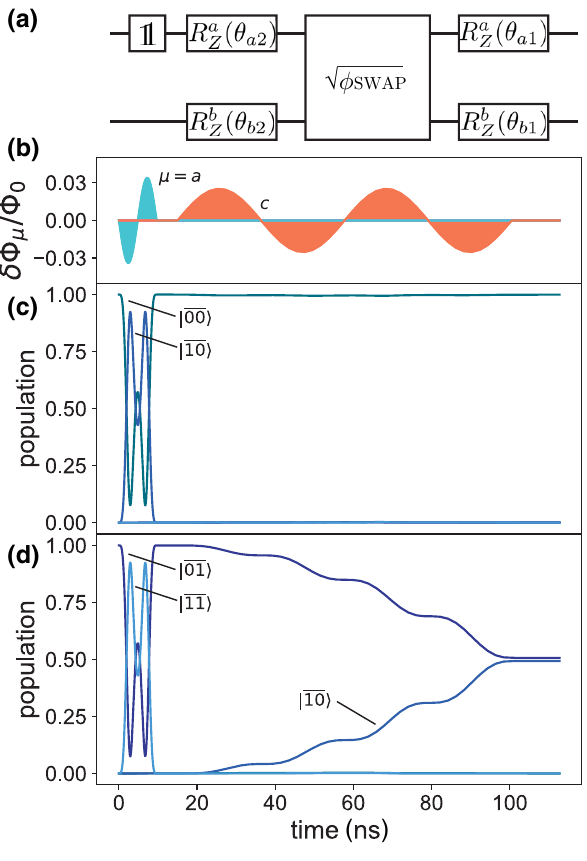
√ √ φ SWAP gate and FIG. 8. A i SWAP gate composed of a corrective Z rotations. (a) A quantum circuit representation of the flux pulses shown in (b). The qubit flux δφ a ( t ) (blue) is modulated to achieve the required identity operation, while the coupler flux δφ c ( t ) (orange) is activated to entangle the qubits. Single-qubit Z rotations are obtained during the time spent idling. (c) The time evolution with the initial state | 00 (cid:5) . The popula- tion transfer to the | 11 (cid:5) or other states is negligible during the √ φ SWAP time window. (b) The time evolution for | 01 (cid:5) as the initial state. The | 01 (cid:5) and | 10 (cid:5) states exchange population during the segment when the coupler flux is nonzero. The closed-system √ fidelity of the i SWAP gate is F =